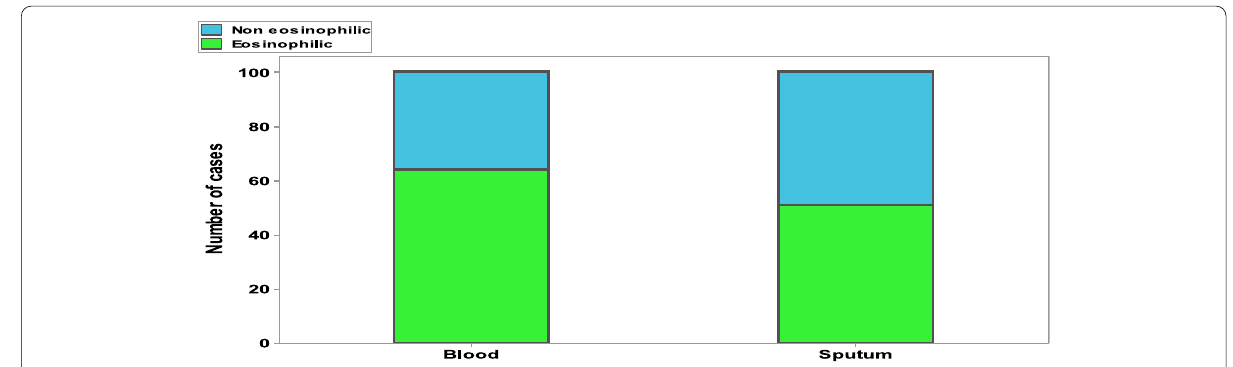
Fig. 1 Eosinophilic phenotype in COPD cases